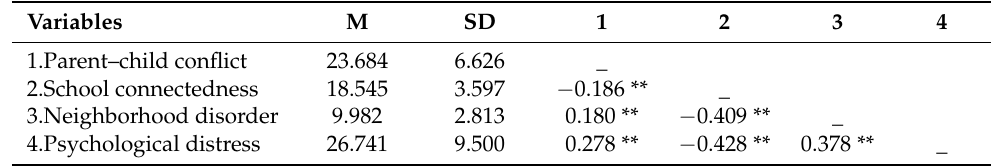
Table 1. Means, SDs, and correlations between key